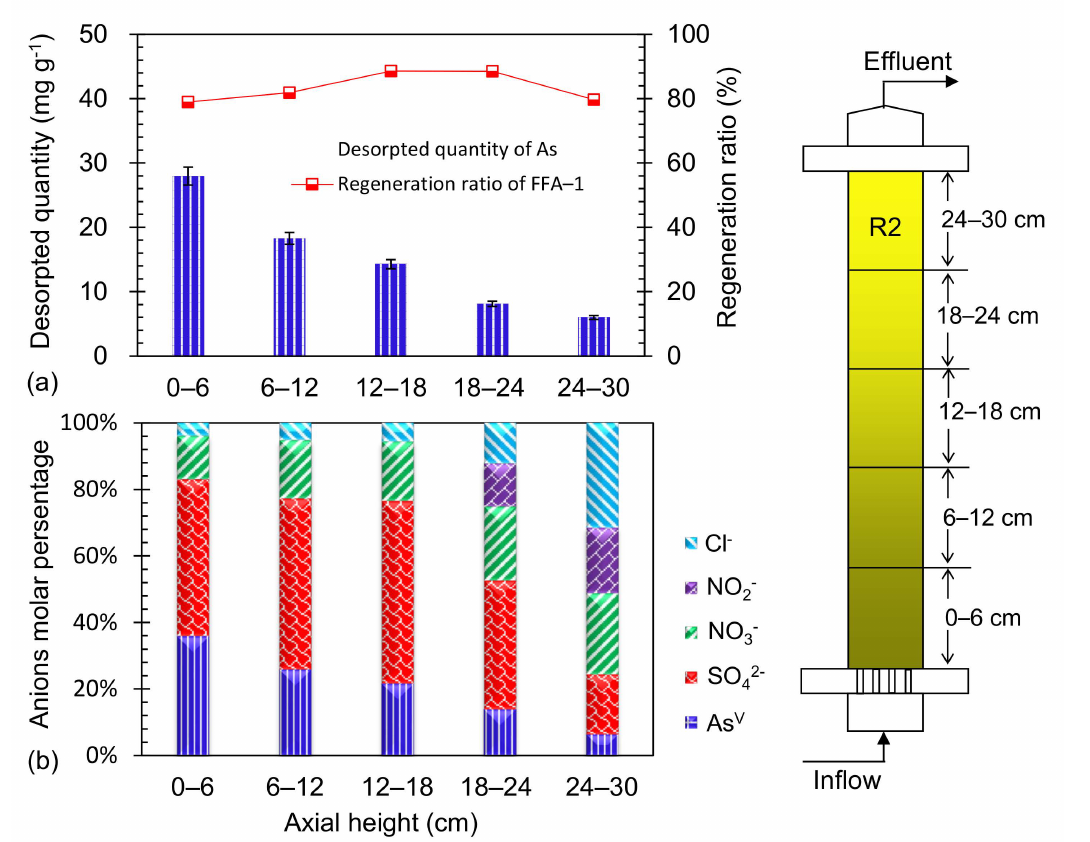
Figure 5. Characterization of FFA-1 at various axial height of R2; quantity of desorbed As and regeneration ratio of FFA-1 ( a ); distribution of various anions trapped by FFA-1 in R2 ( b